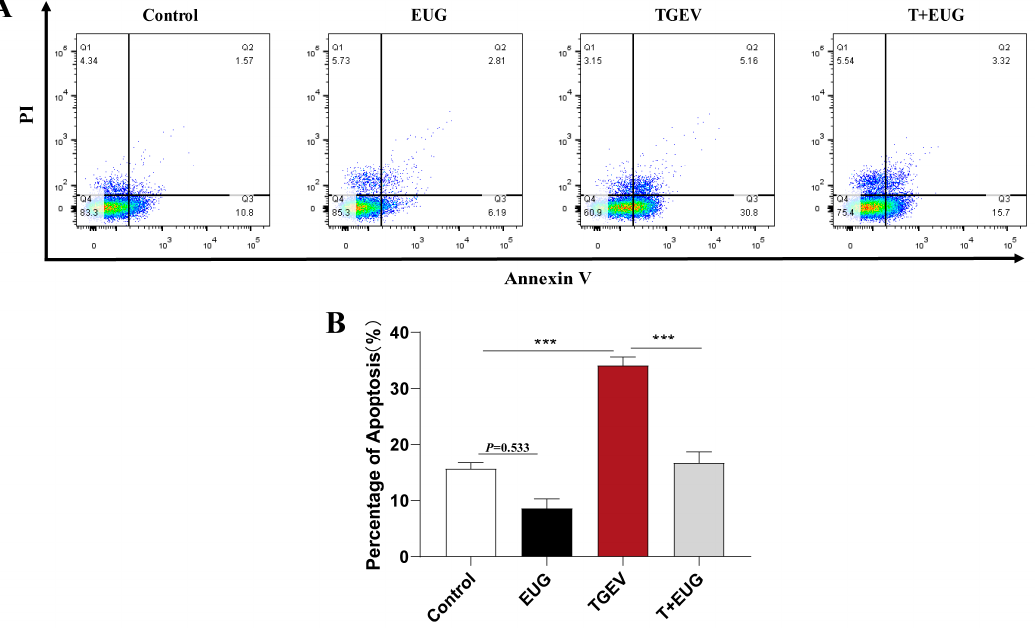
Figure 5. Eugenol alleviates TGEV-induced jejunal epithelial cell death in piglets. ( A , B ) The flow cytometry assays detecting the percentage of apoptosis in jejunum epithelial cells ( n = 6–8). Data are expressed as the mean ± SEM. *** p < 0.001.